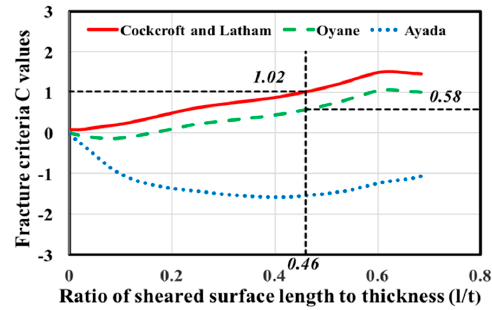
Figure 5. Relationships between fracture criteria ( C ) values and ratio of sheared surface length to thickness obtained by comparing the cutting surface by FEA with the shear limit point ( l/t ) obtained from the punching experiment for the punch diameter of 10 mm and a clearance of 6.25 %t.